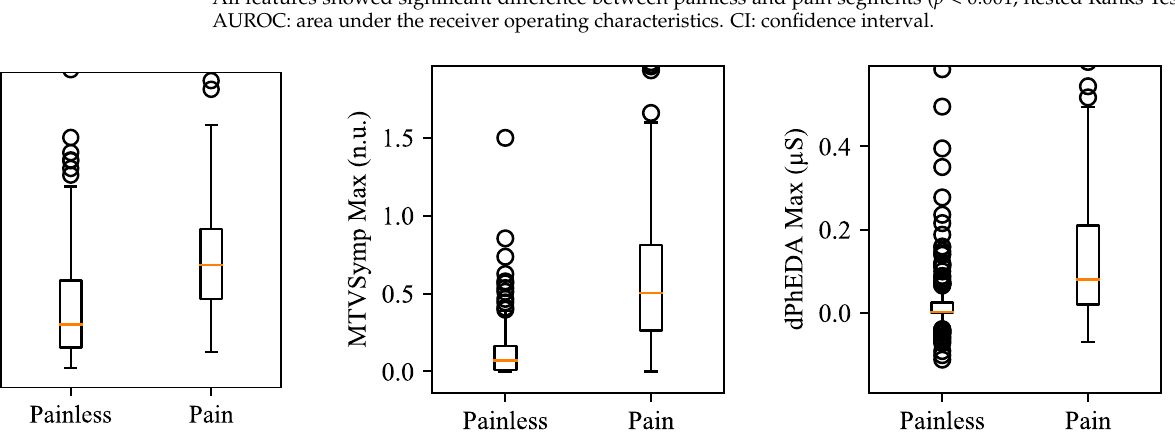
Figure 8. Boxplots for maximum values of TVSymp, MTVSymp, and dPhEDA for both datasets. The circles in the boxplots indicate outliers. Outliers were set if each datum is above Q1 − 1.5 × (Q3 − Q1) or below Q3 + 1.5 × (Q3 − Q1). Q1 and Q3 represent the first and third quartiles, respectively.